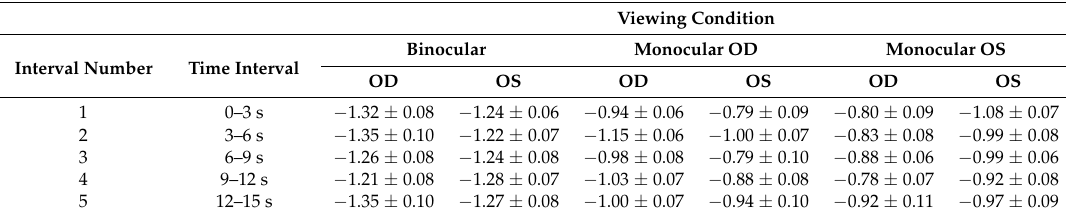
Table 2. Fixation stability quantified by logBCEA (mean ± SD) for each eye during binocular and monocular viewing conditions for the control